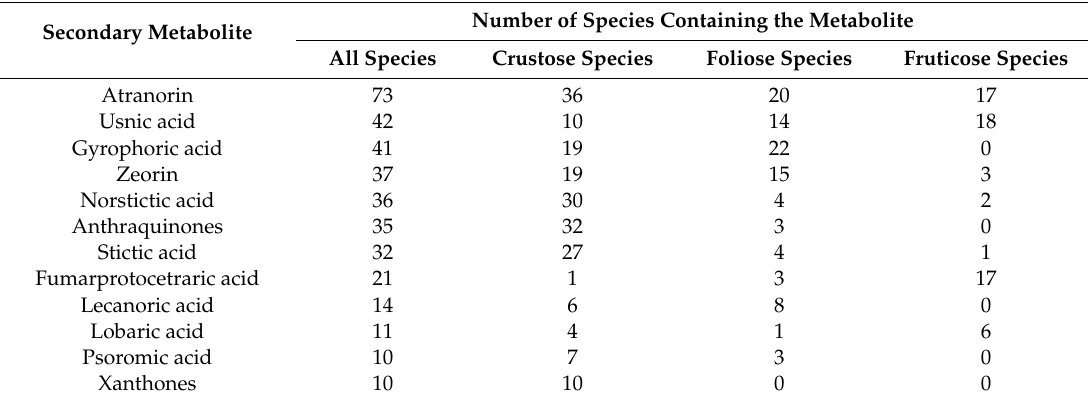
Table 2. Major secondary metabolites of saxicolous lichens of di ff erent morphological groups. Secondary Metabolite